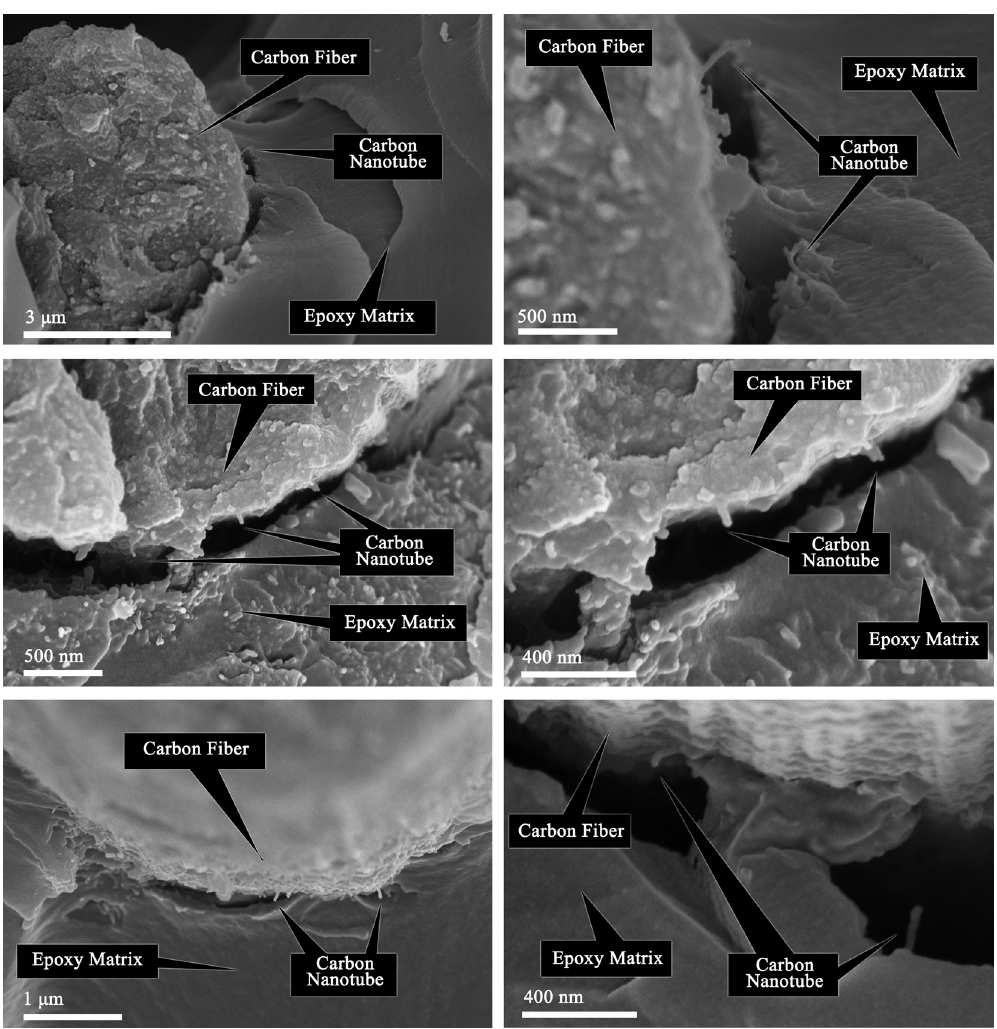
Figure 10: SEM images of the fl exural fractured surfaces of CF –